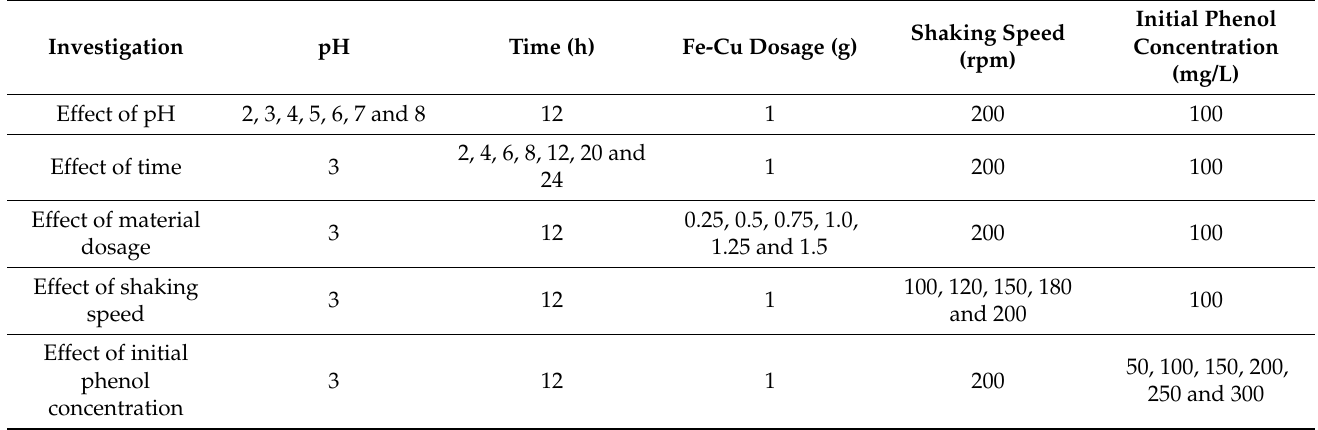
Table 1. Parameters for single factor